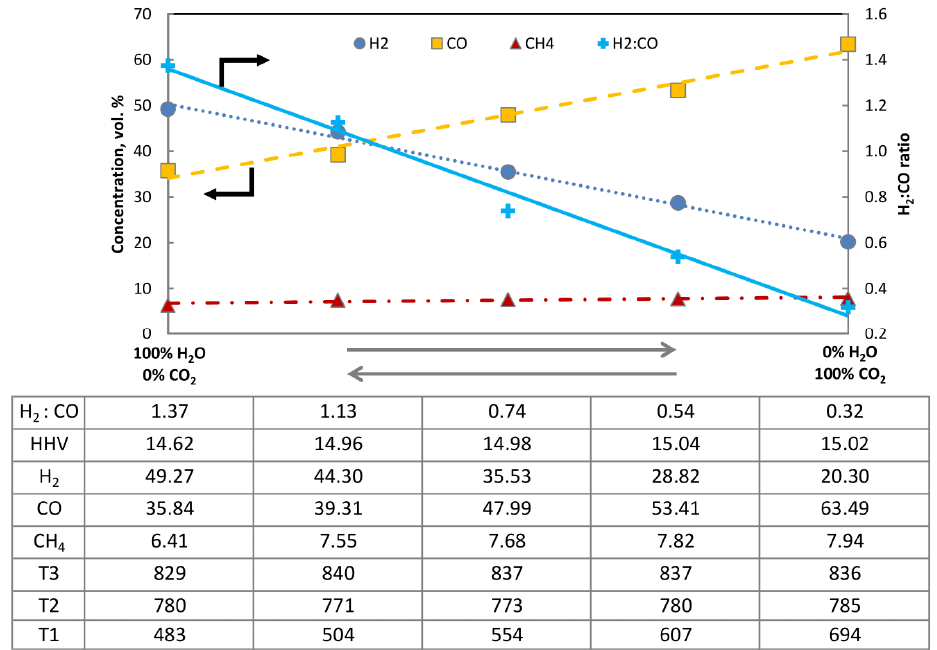
Figure 5. Composition of dry, CO 2 -free producer gas under varying compositions of gasifying agent O 2 /H 2 O–O 2 /CO 2 (bark, 850 ◦ C 1 bar g